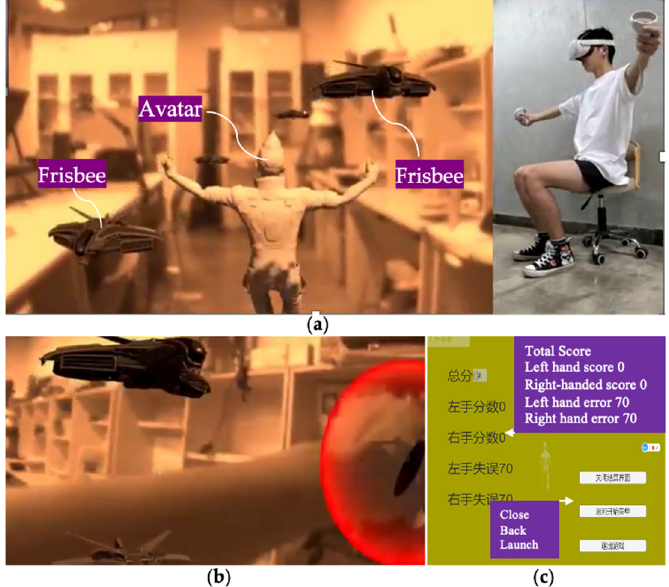
Figure 2. Under the proposed system, ( a ) An avatar, virtual targets, and physical environment can be observed, and ( b ) a user’s hand can be seen and promoted. ( c ) an interface appears at the end of the training, presenting the system’s evaluation of a user’s rehabilitation.